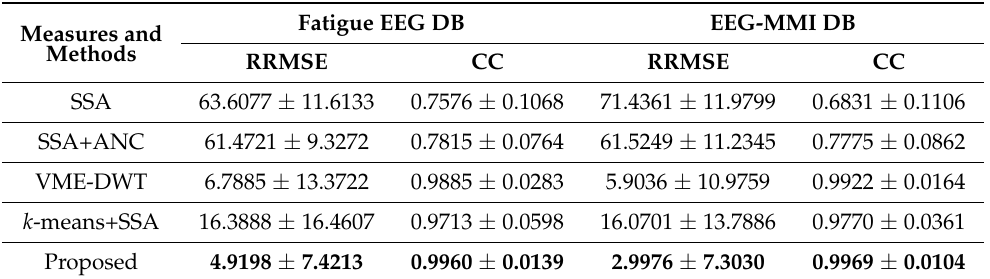
Table 1. RRMSE and CC ( µ ± σ ) comparison between the non-artifact interval of contaminated and corrected EEG signals.